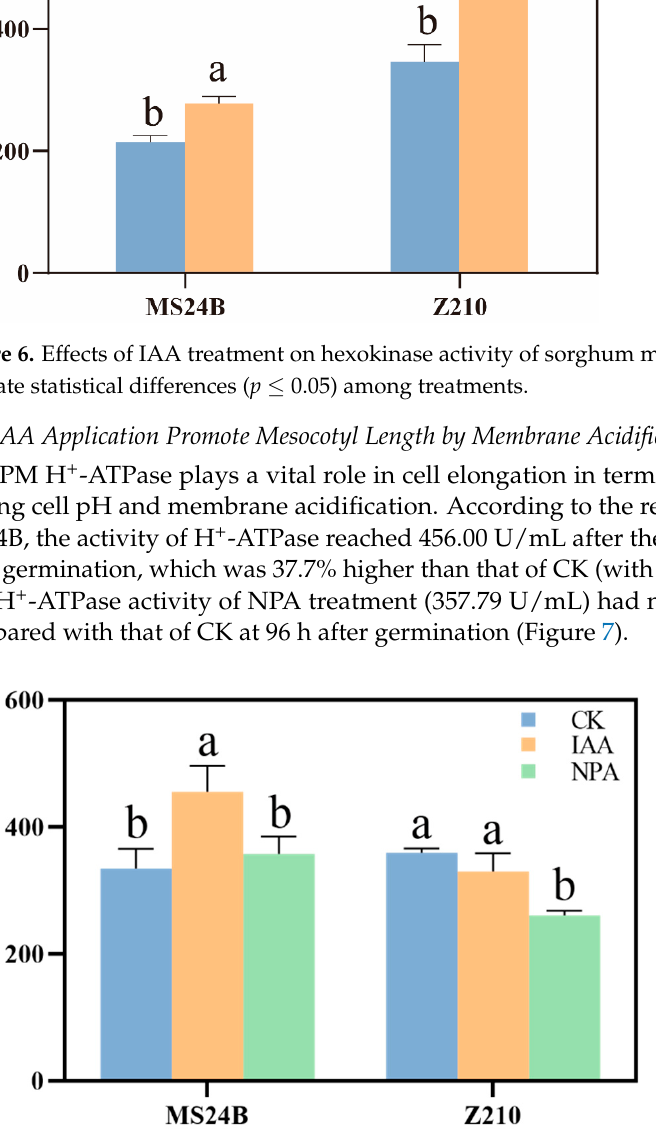
Figure 5. Effects of IAA and NPA treatment on starch content, total amylase activity, and seed sol- uble sugar of different sorghum inbred lines during germination. ( A ) Total starch content changes from 0 h to 108 h after germination in MS24B; ( B ) Total starch content changes from 0 h to 108 h after germination in Z210; ( C ) Total amylase activity changes from 0 h to 108 h after germination in MS24B; ( D ) Total amylase activity changes from 0 h to 108 h after germination in Z210; ( E ) Soluble sugar content changes from 0 h to 108 h after germination in MS24B; ( F ) Soluble sugar content changes from 0 h to 108 h after germination in Z210. Lowercase letters indicate statistical differences ( p ≤ 0.05) among treatments.